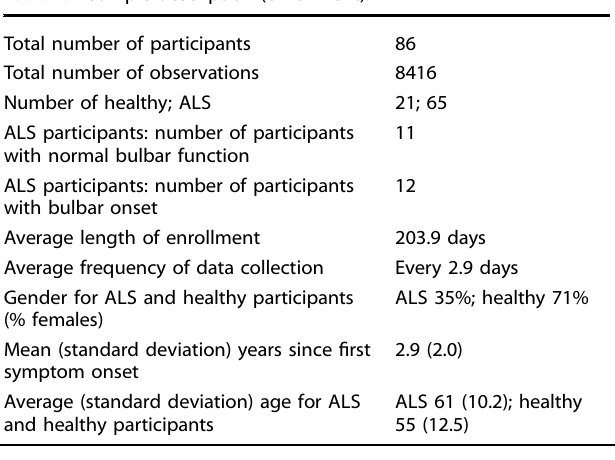
Table 1. Sample description (enrollment).